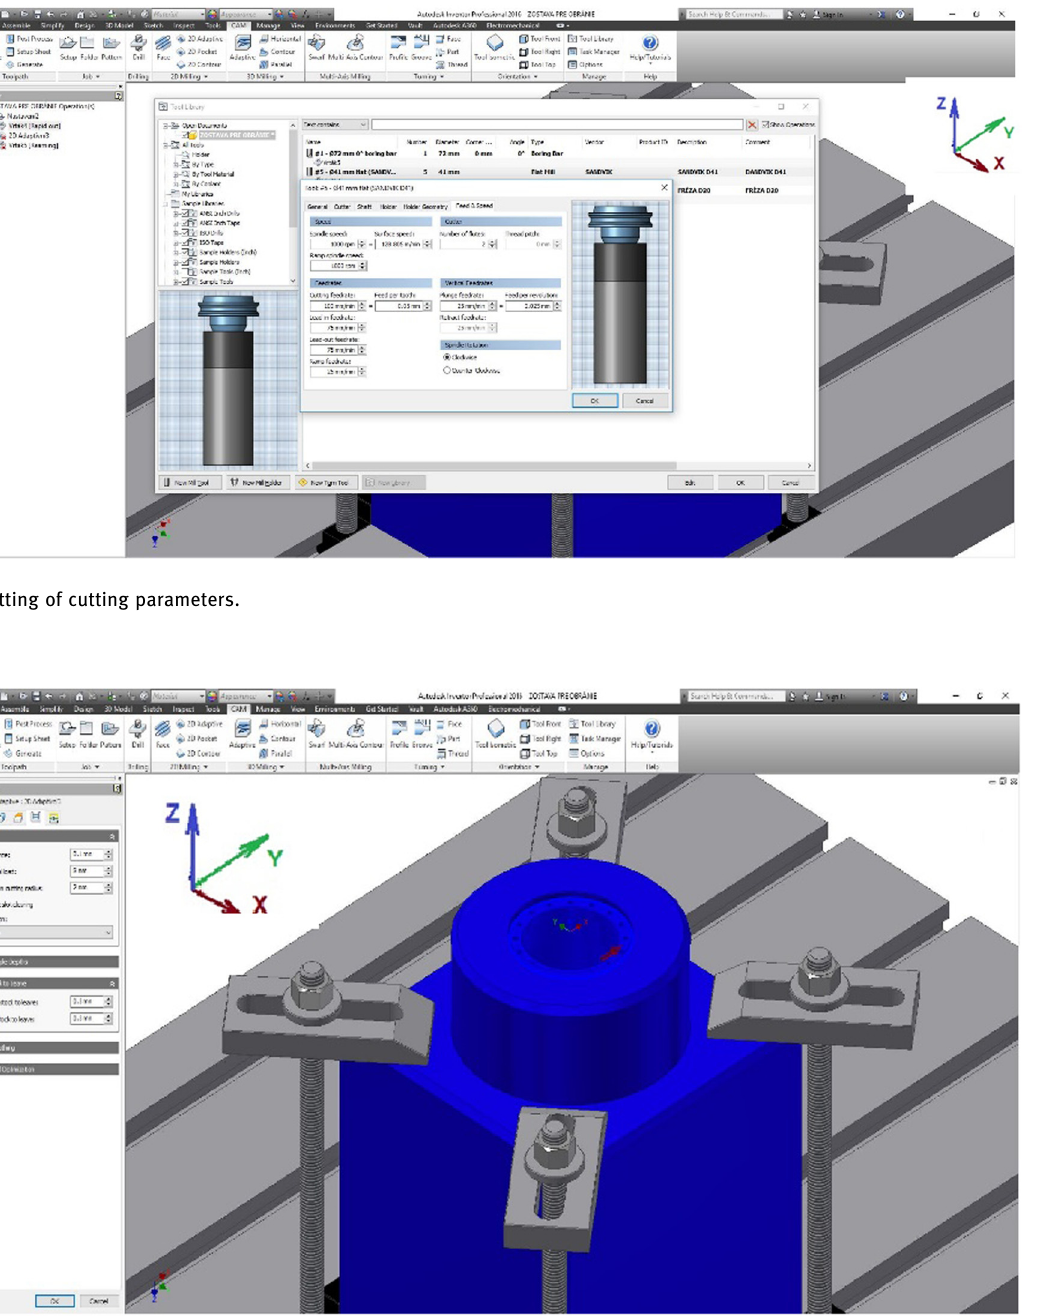
Figure 6: De fi ning of adaptive milling